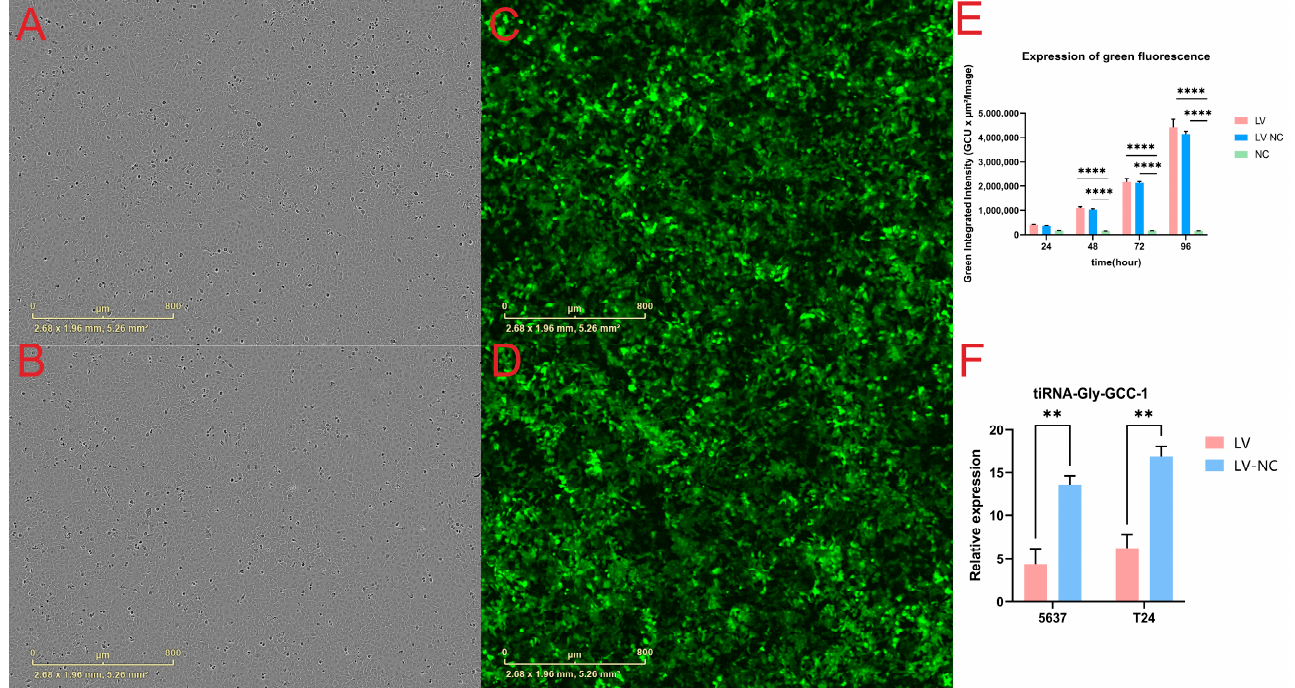
Figure 1. The expression of green fluorescence and down-regulation of tiRNA-Gly-GCC-1 after lentivirus transfection (transfection group, LV; negative control group, LV-NC; blank group, NC). The bright field of cells in LV group ( A ) and LV-NC group ( B ) at 96 h post-transfection in 96-well plates. The GFP-tagged lentiviral plasmids in LV group ( C ) and LV-NC group ( D ) at 96 h post-transfection in 96-well plates. ( E ) The total green object integrated intensity (GCU × μ m 2 /image) in three cell groups (n = 5 wells per group). ( F ) Relative expression of tiRNA-Gly-GCC-1 of T24 and 5637 cells in LV and LV-NC group (n = 3 wells per group). The data were normalized using the mean ± SEM. ** indicates p -value < 0.01. **** indicates p -value < 0.0001.